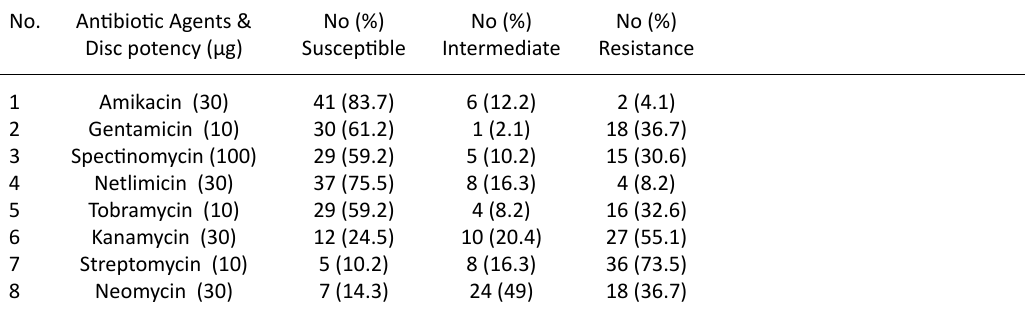
Table 3. Resistance profile of Enterobacterial isolates to different aminoglycosides No.